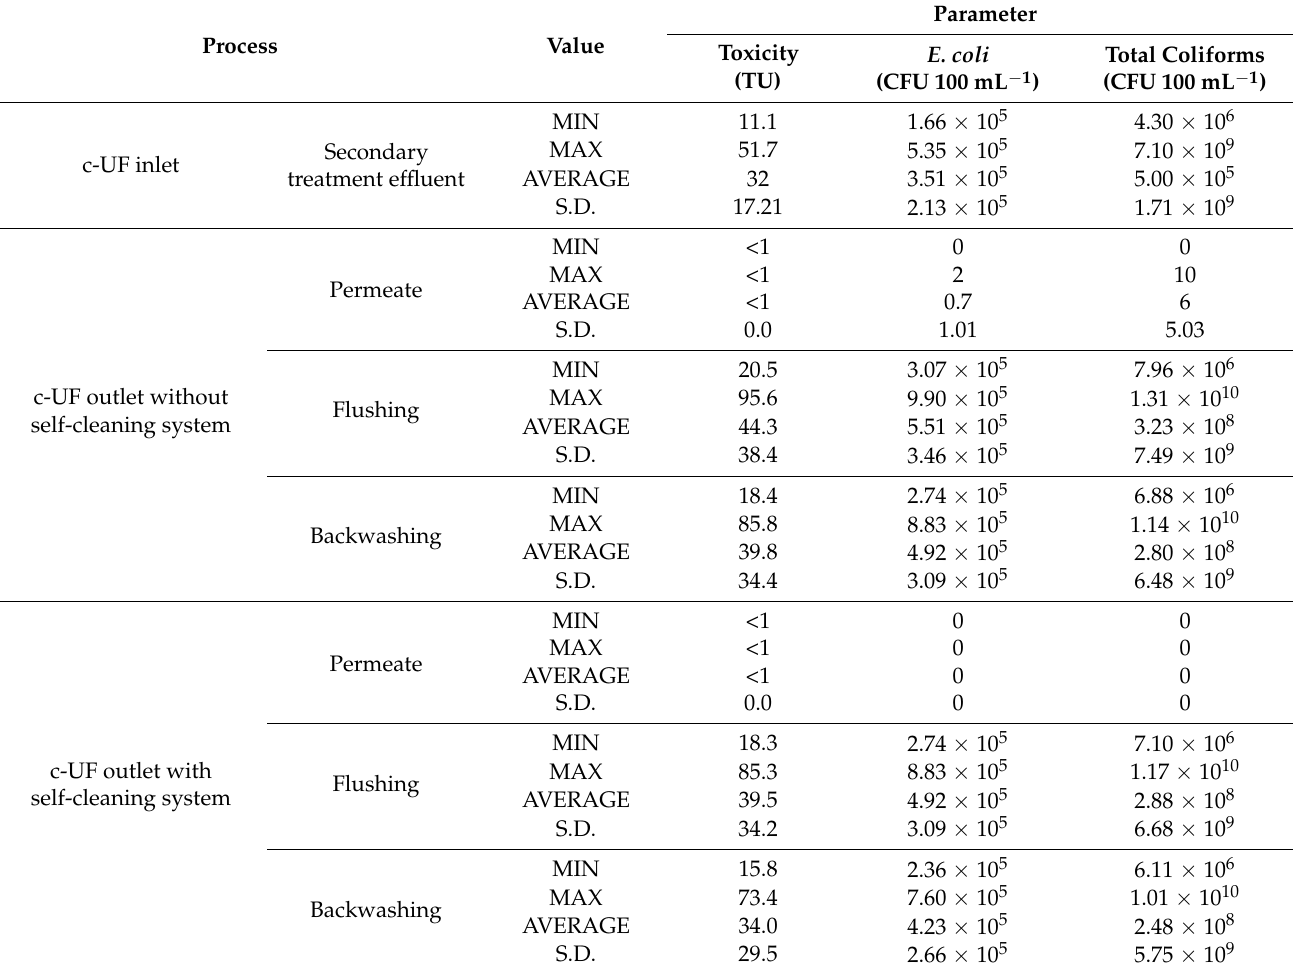
Table 5. Evaluation of the removal of toxicity and microbial density using c-UF technology with and without a self- cleaning